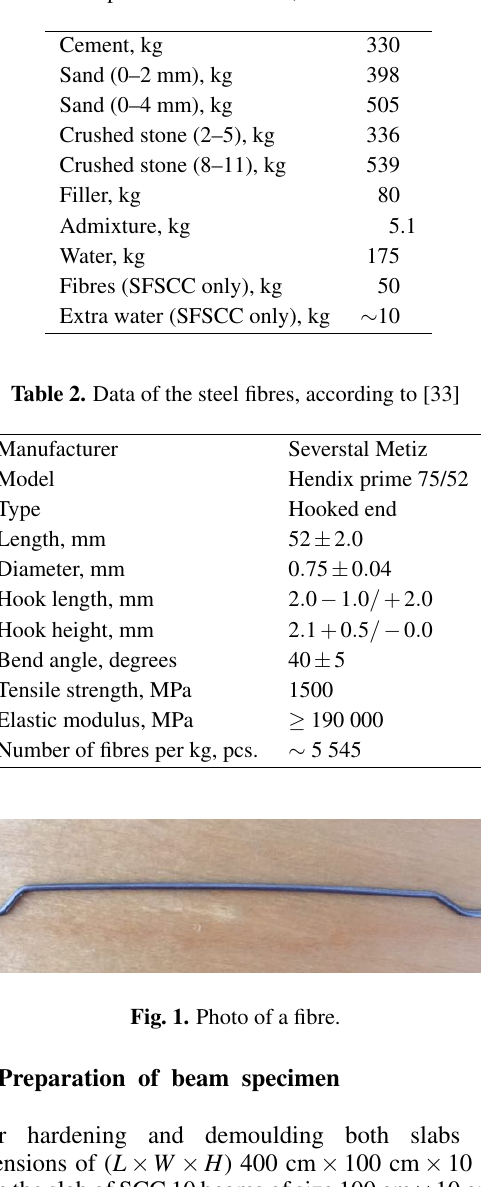
Table 1. Composition of SCC mix, amount mixed: 1 m 3